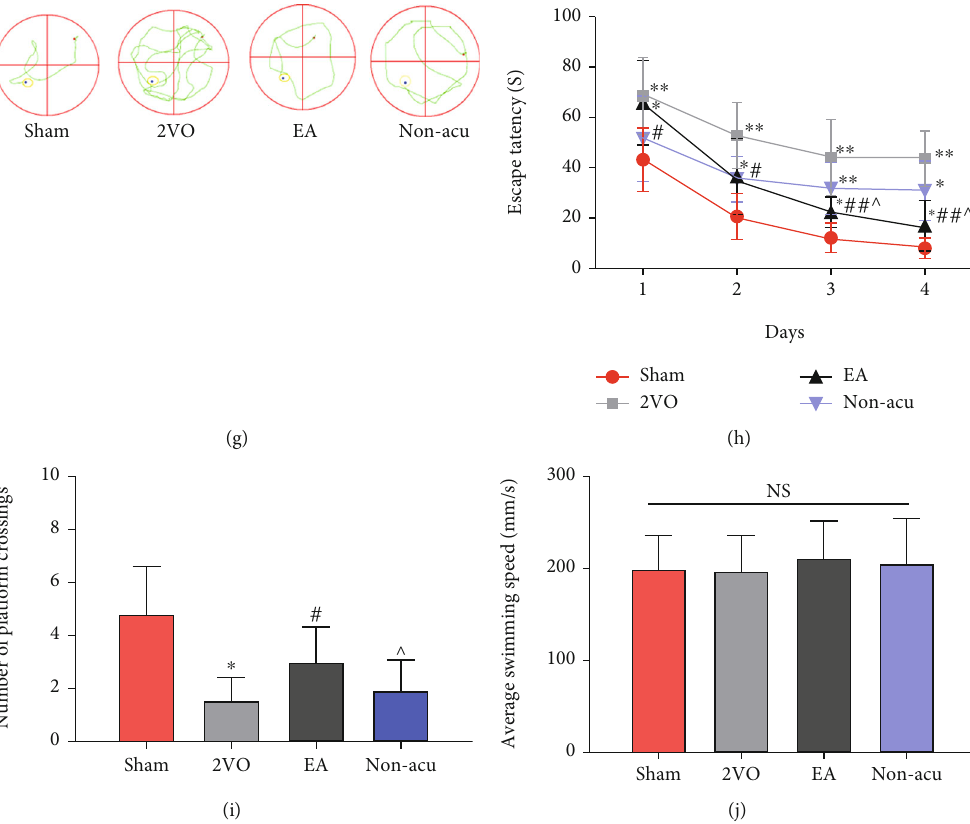
Figure 1: Assessment of MRI and learning and memory behaviours in rats with VCI. (a) Experimental fl owchart. (b) Schematic diagram of acupuncture. (c) Experiment timeline. (d) Model group 3D-TOF imaging of bilateral common carotid arteries in the sham operation group indicated via red arrows. (e) New object recognition test (1 h) in each group of rats before the intervention. (f) New object recognition test (24 h) for each group of rats before the intervention. ∗ P < 0 : 05 ; ∗∗ P < 0 : 01 . (g) Typical trajectory diagram for each group in the water maze. (h) Results of water maze escape latency in various groups of rats. (i) Number of times rats crossed the platform in each group. (j) Mean swimming speed for each group of rats. ∗ P < 0 : 05 and ∗∗ P < 0 : 01 , Sham vs. 2VO; # P < 0 : 05 , 2VO vs. EA; ^ P < 0 : 05 , EA vs.